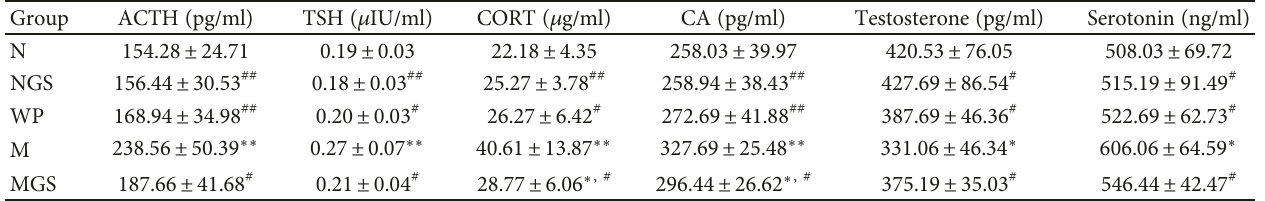
Table 2: Serum concentrations of ACTH, TSH, CORT, CA, testosterone, and serotonin.